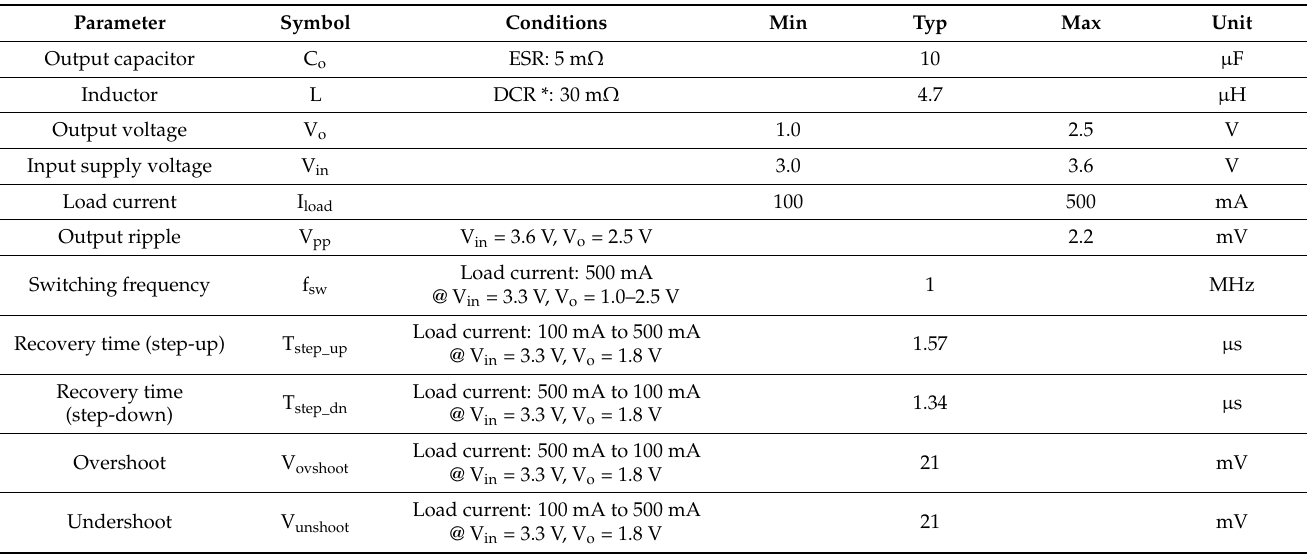
Table 2. Performance of Proposed Converter.